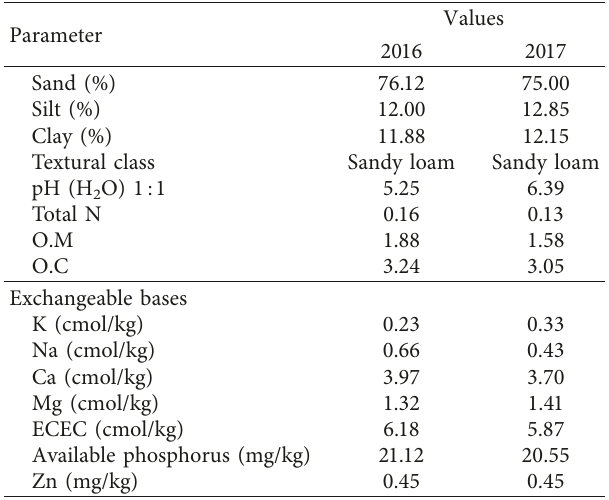
Table 1: Soil physical and chemical properties prior to planting